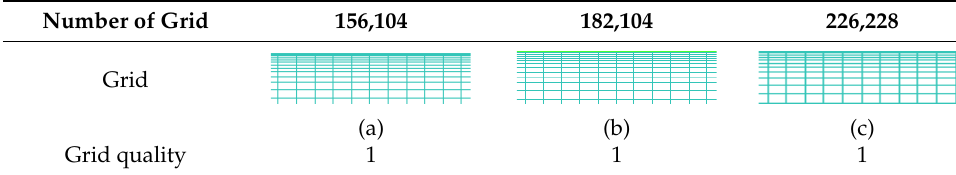
Table 4. The local boundary layer grid of three grids.